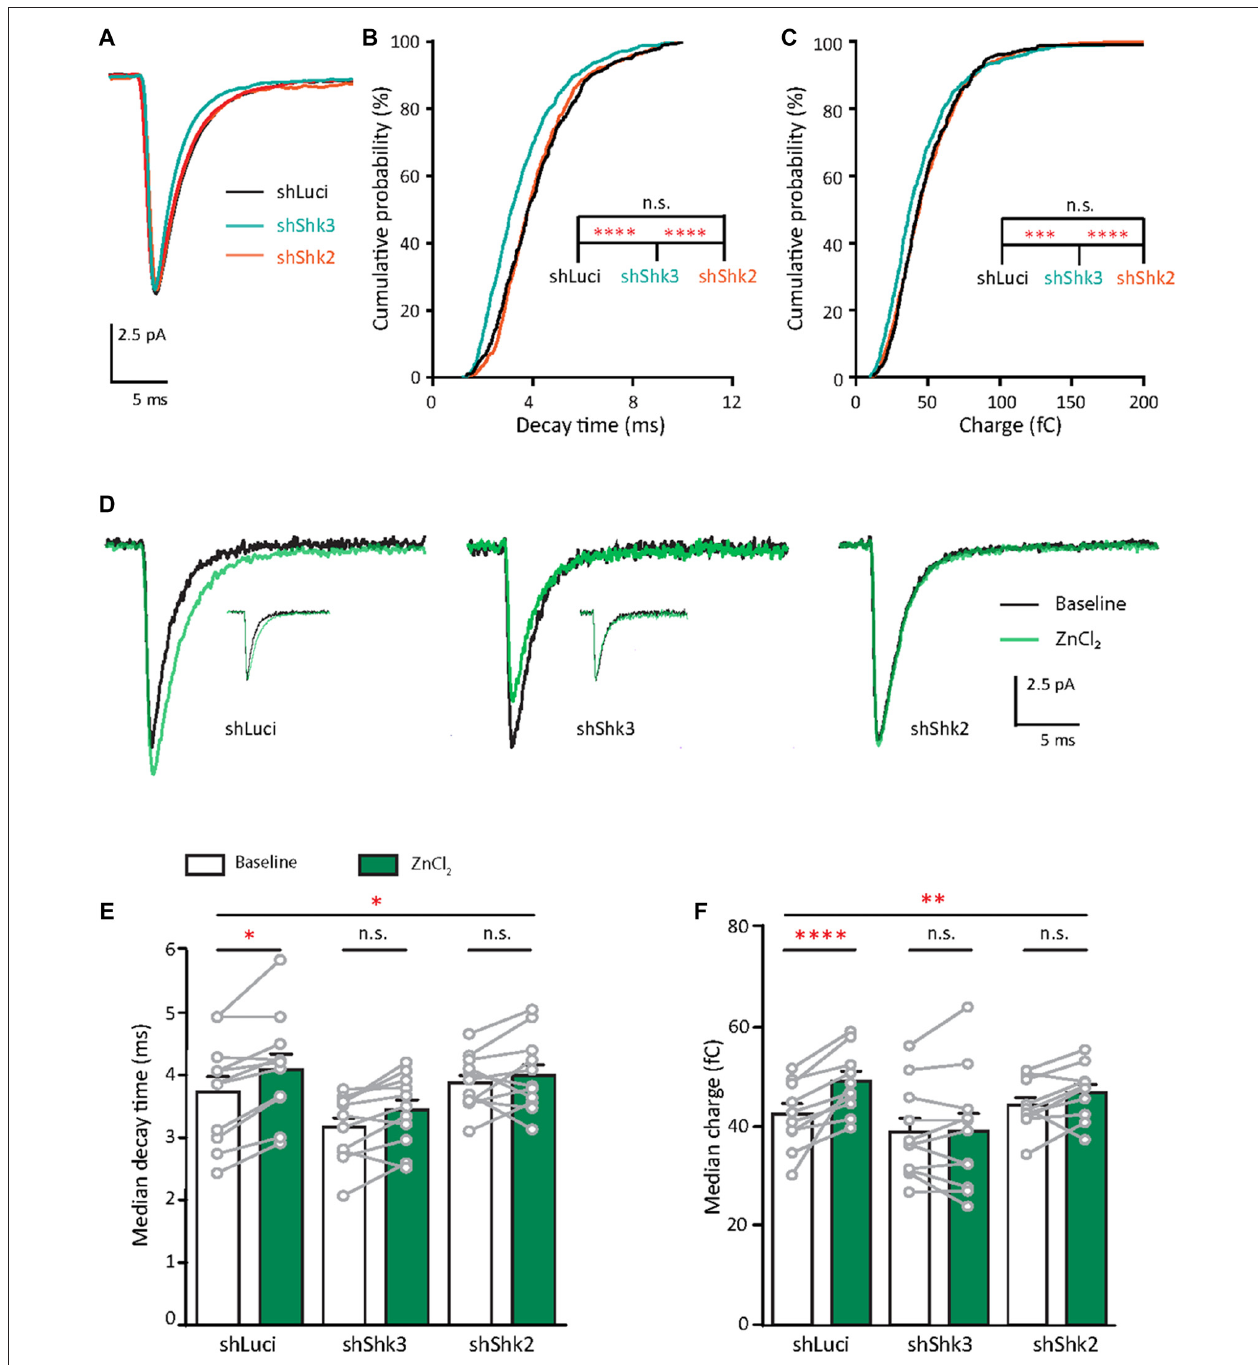
FIGURE 11 | Shank knockdown alters AMPAR function and suppresses their zinc-dependent changes. (A) Ensemble-averaged mEPSCs from recordings of hippocampal neurons infected with lentiviruses expressing shLuci (black), shShk3 (blue) or shShk2 (orange; N = 11 cells per condition from five to seven culture preps per condition). (B,C) Cumulative probability histograms of decay time (B) and charge (C) of isolated events of different conditions (Kruskal-Wallis one-way ANOVA followed by Dunn’s correction post hoc multiple comparisons, N = 400–600 events from 11 neurons from five to seven culture preps per condition; n.s. p ≥ 0.05, ∗∗∗ p < 0.001, ∗∗∗∗ p < 0.0001). (D) Average mEPSCs from recordings at baseline (black) and zinc (green) conditions of individual hippocampal neurons infected with lentiviruses expressing shLuci (left), shShk3 (middle) or shShk2 (right; N = 11 cells from five to seven culture preps per condition). mEPSCs normalized to baseline response are shown in corresponding insets to differentiate effect of zinc on decay kinetic. (E,F) Summary graphs with per-cell-basis pairwise comparisons of decay time (E) and charge (F) between baseline and ZnCl 2 conditions in different conditions (median ± SEM; two-way ANOVA; ∗ p < 0.05, ∗∗ p < 0.01. Sidak correction multiple post hoc comparisons, N = 10–11 cells from five to seven culture preps per condition; n.s. p ≥ 0.05, ∗ p < 0.05, ∗∗∗∗ p < 0.0001).